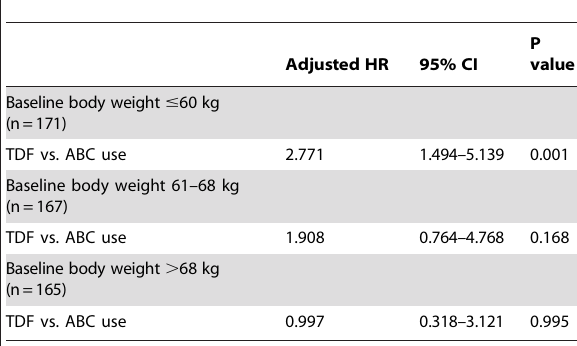
Table 4. Multivariate analysis to estimate the risk of TDF- over ABC-based antiretroviral therapy in the induction of more than 25% fall in eGFR according to baseline body